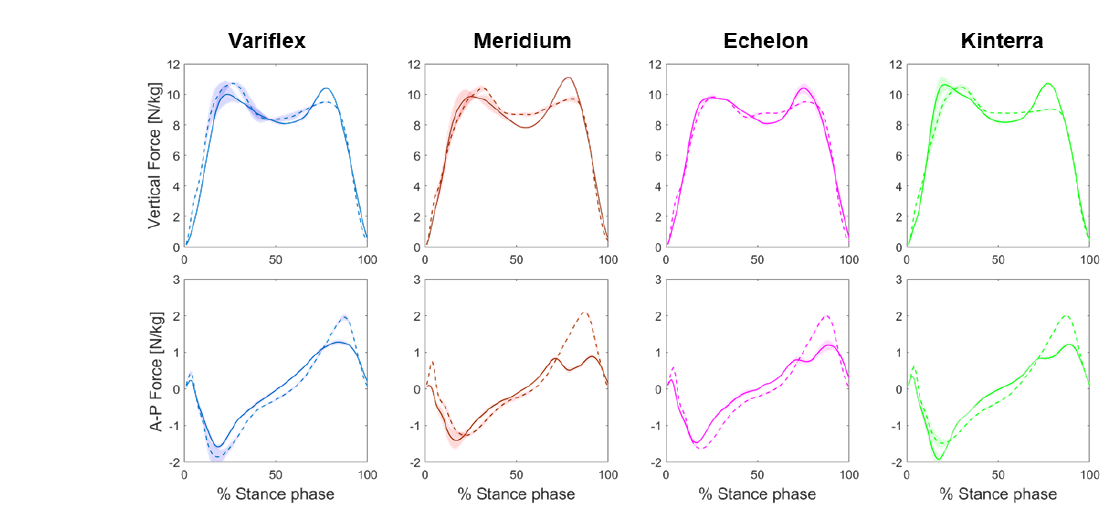
Figure 3. Mean vertical and anterior–posterior components of the ground reaction force patterns during stance at different prostheses’ conditions. Forces of the amputated leg are presented in a continuous line, and that of the unaffected leg is presented in a dotted line. The shaded region denotes the standard deviation.